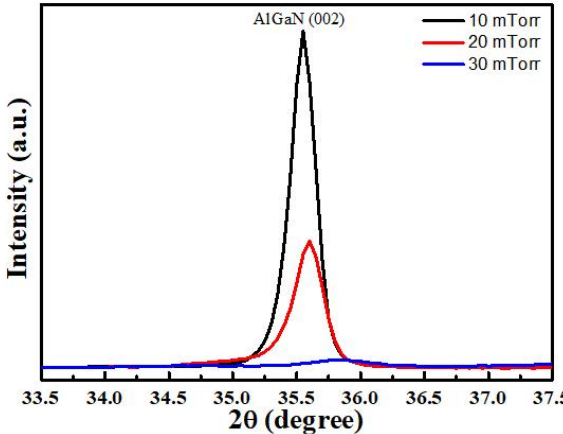
Figure 2. XRD patterns of the AlGaN films deposited under different sputtering pressures.